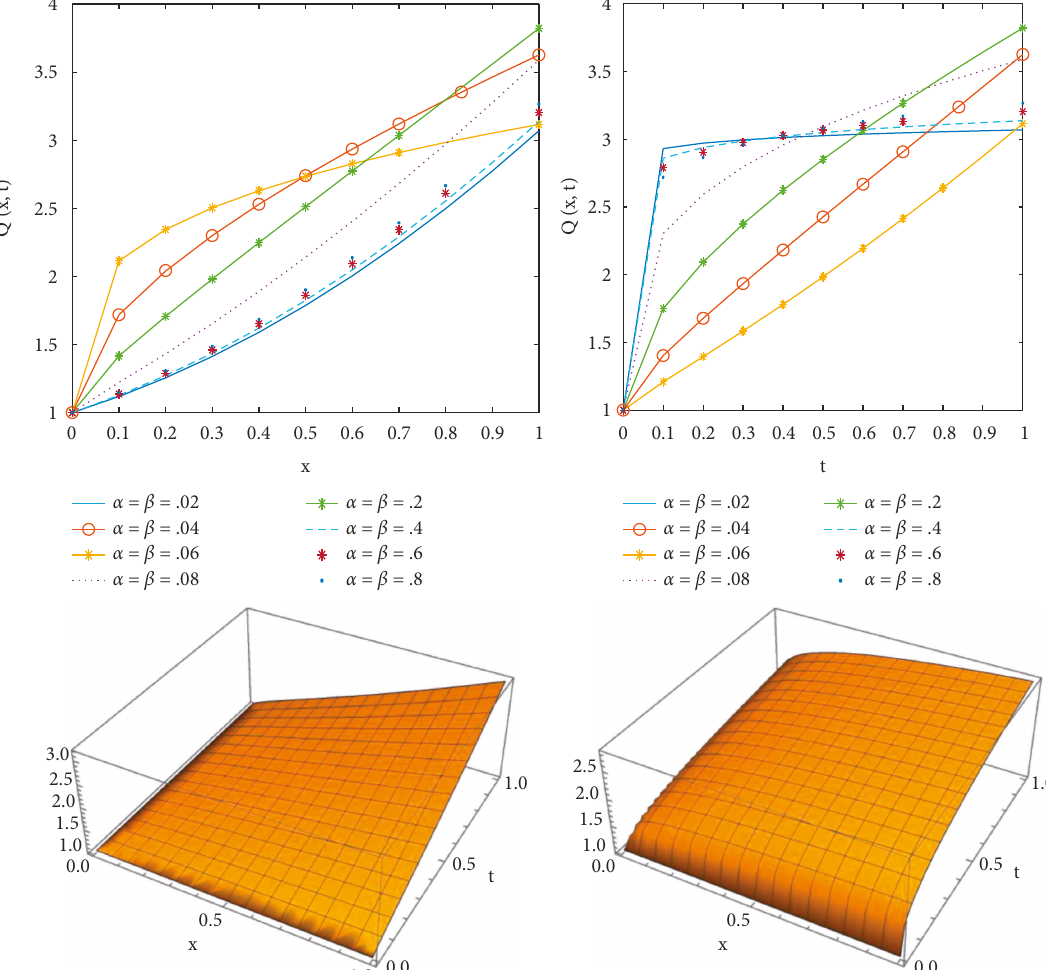
Figure 3: Comparison of the solution at various values of alpha and